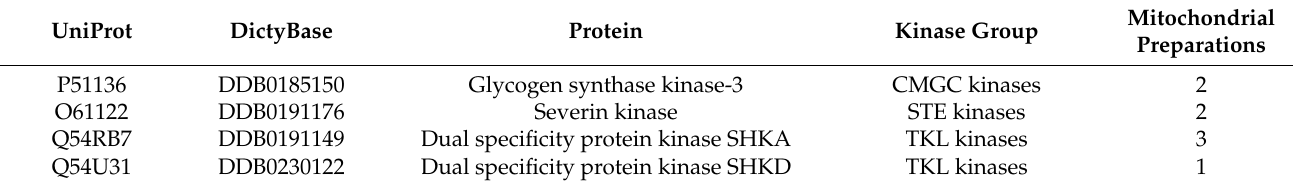
Table 2. Kinases identified in mitochondrial preparations from D. discoideum WT and HPF444 strains. UniProt, Universal Protein Resource database; DictyBase, Dictyostelium discoideum genome database; Protein, protein name; Mitochondrial preparations, number of mitochondrial preparations in which a given kinase and its phosphorylation site were